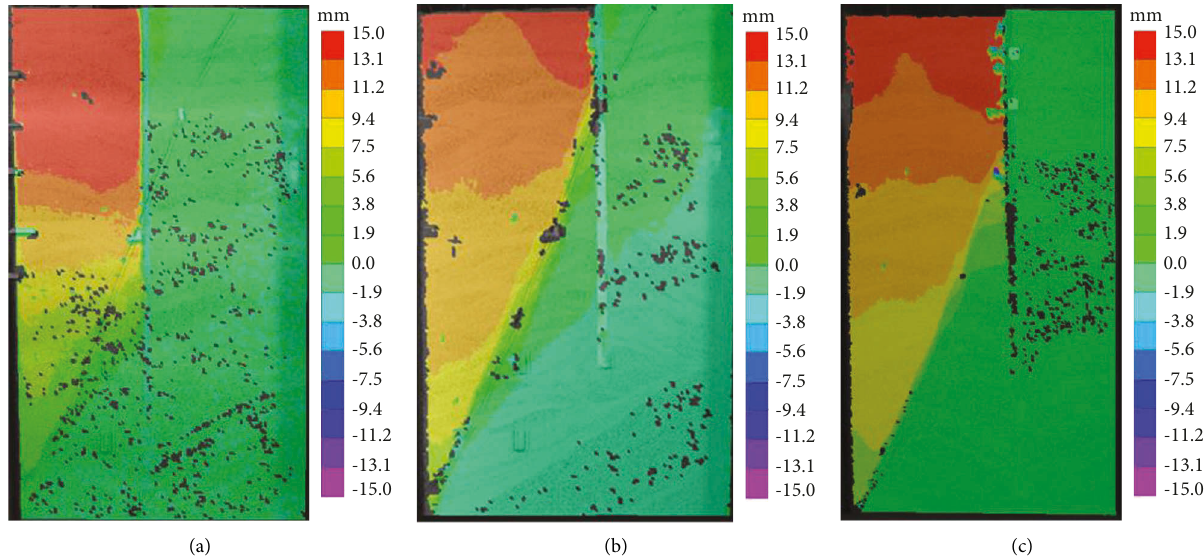
Figure 13: The vertical settlement field in samples (a) M4, (b) M5, and (c)